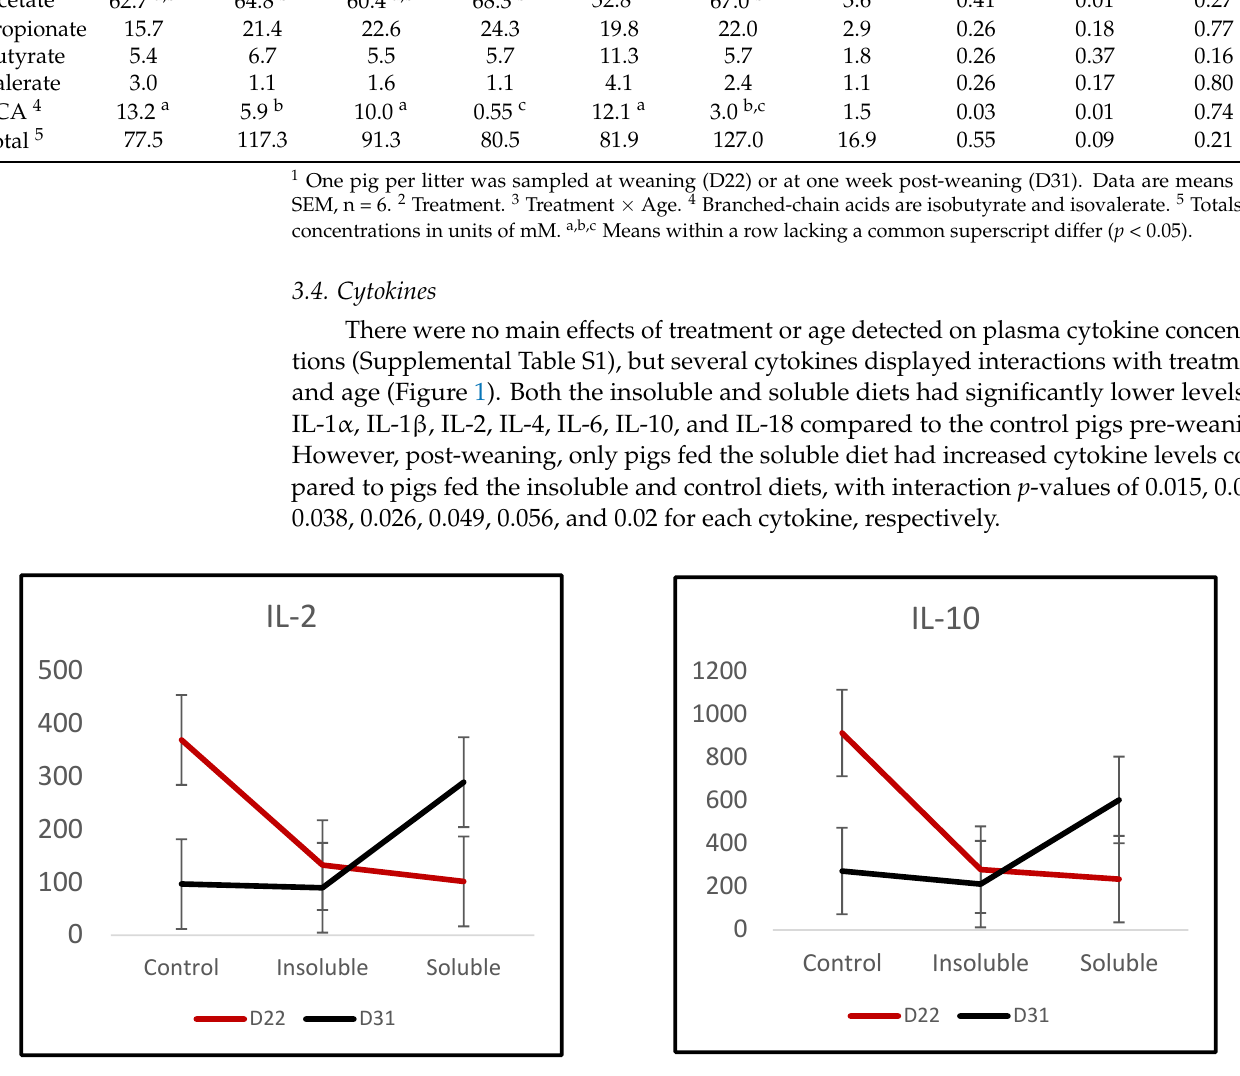
Figure 1. Plasma IL- 2 and IL-10 concentrations (pg/mL) in pigs fed insoluble or soluble gruel creep diets, measured before (D22) or after (D31) weaning, compared with non-creep-fed controls. Significant effects of diet and age were not detected ( p > 0.1). Treatment by age interaction ( p < 0.05). Similar interactions were observed for IL-1 α , IL-1 β , IL-4, IL-6, and IL-18 (see Supplemental Table S1).